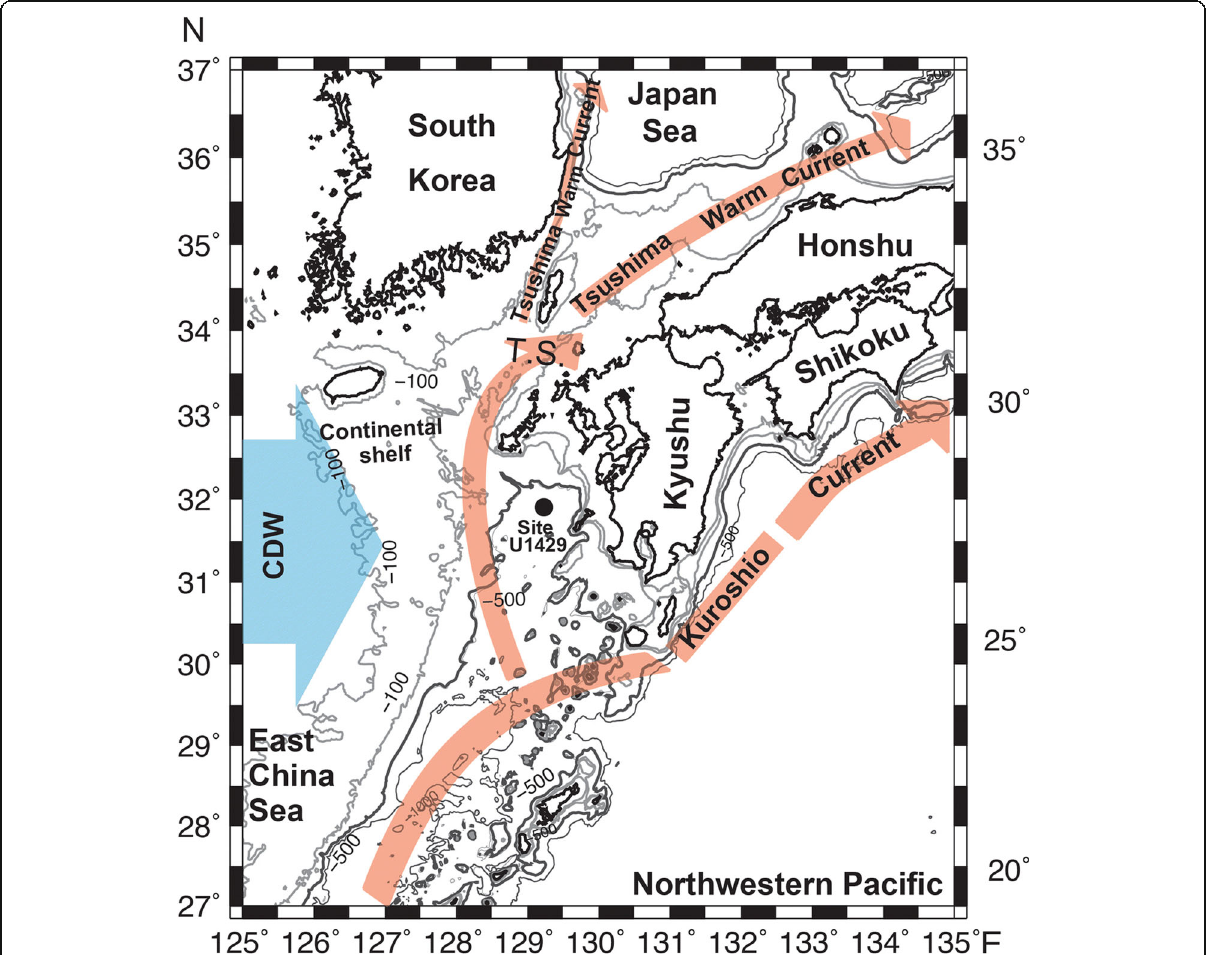
Fig. 1 Map from Matsuzaki et al. (2016) modified for this study to show the location of site U1429 and the key oceanographic features of the study area. CDW means Changjiang diluted water and IODP means Integrated Ocean Drilling